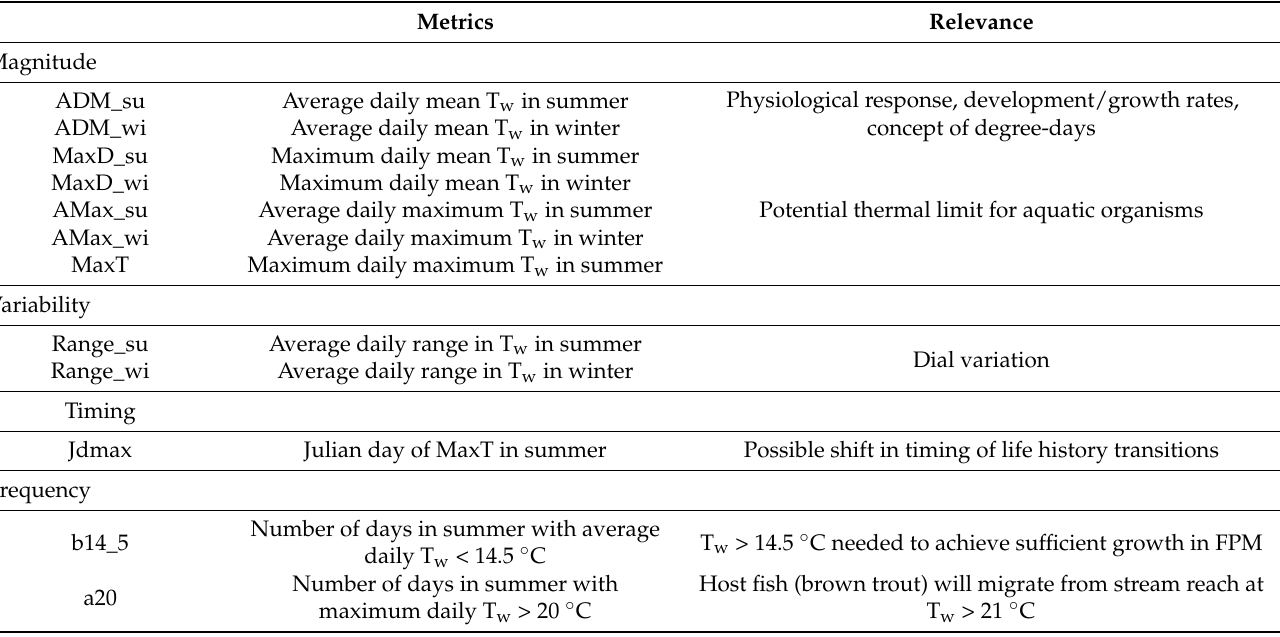
Table 3. Temperature metrics used to describe the thermal regime at the monitoring points, and their ecological relevance. Metrics